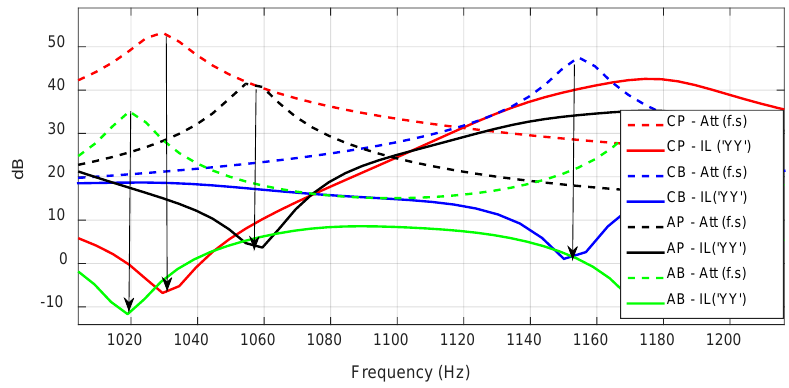
Figure 20. IL (solid lines) with double-Y caps in the four configurations (CP, Car–Person; CB, Car–Balcony; AP, Ambulance–Person; AB, Ambulance–Balcony) and attenuation losses (dashed lines) in free space (‘Att (fs)’, without barrier) in the corresponding receiver locations.